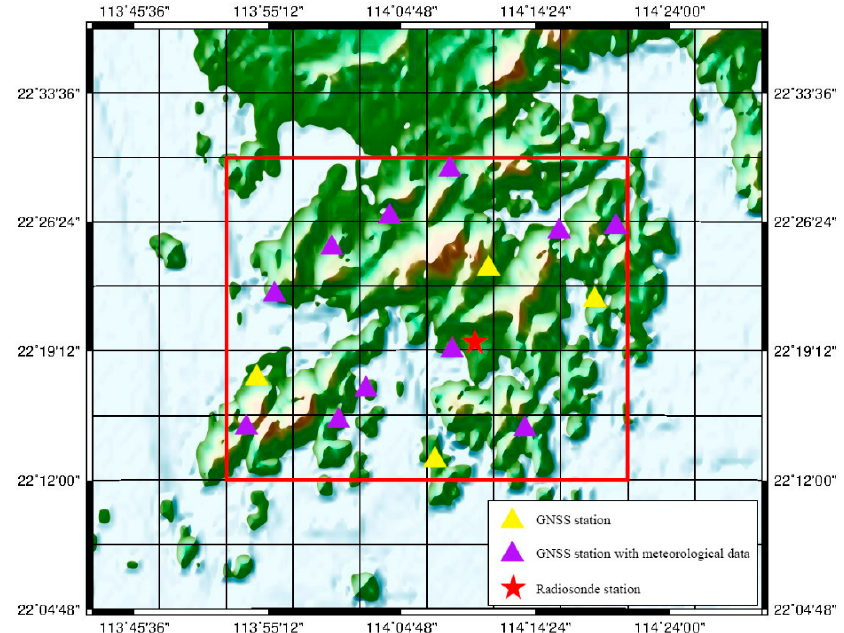
Figure 1. Tomographic region (square with red outline) and geographical distribution of GNSS, meteorological and radiosonde stations. The yellow triangles denote the GNSS stations without meteorological sensors; the purple triangles denote the GNSS stations with meteorological observations; the red star denotes the radiosonde station.